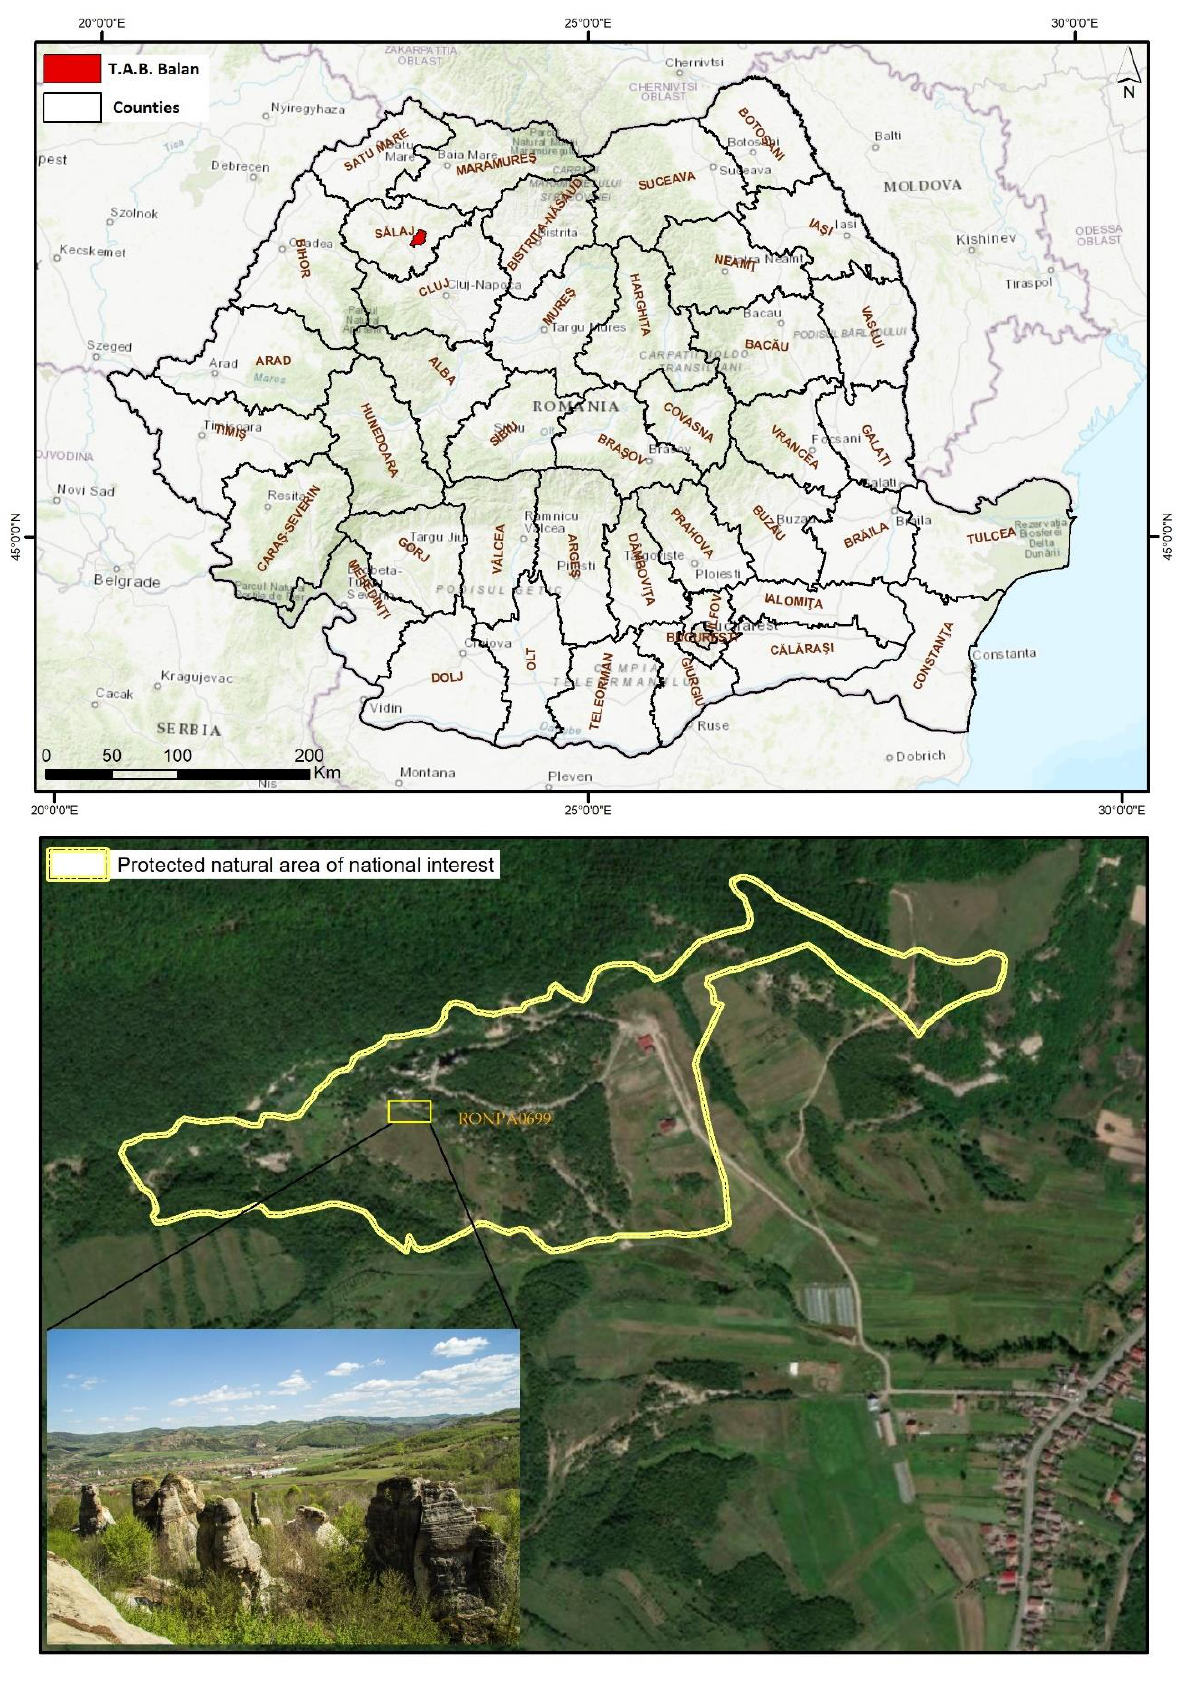
Figure 1. The territorial location of the Grădina Zmeilor geomorphosite .